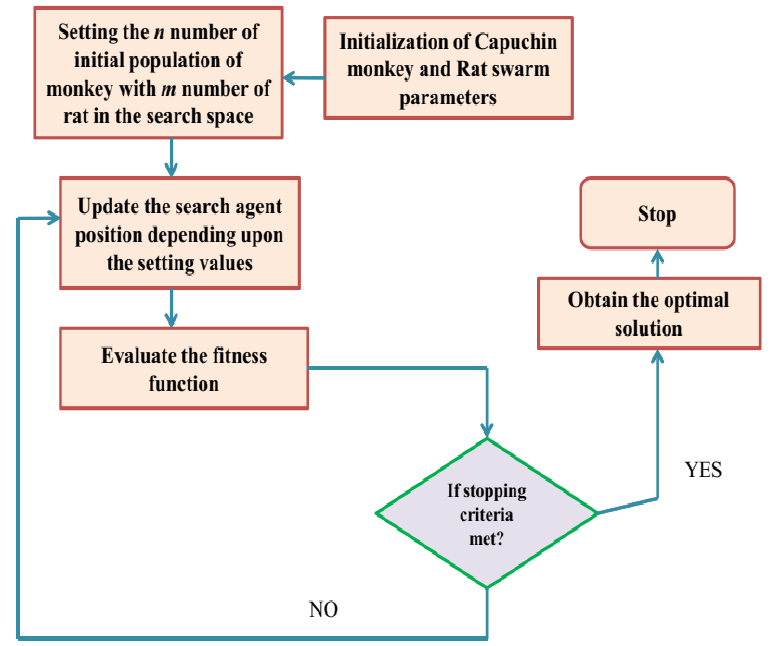
Figure 2. Flow chart representation of hybrid CRS algorithm .